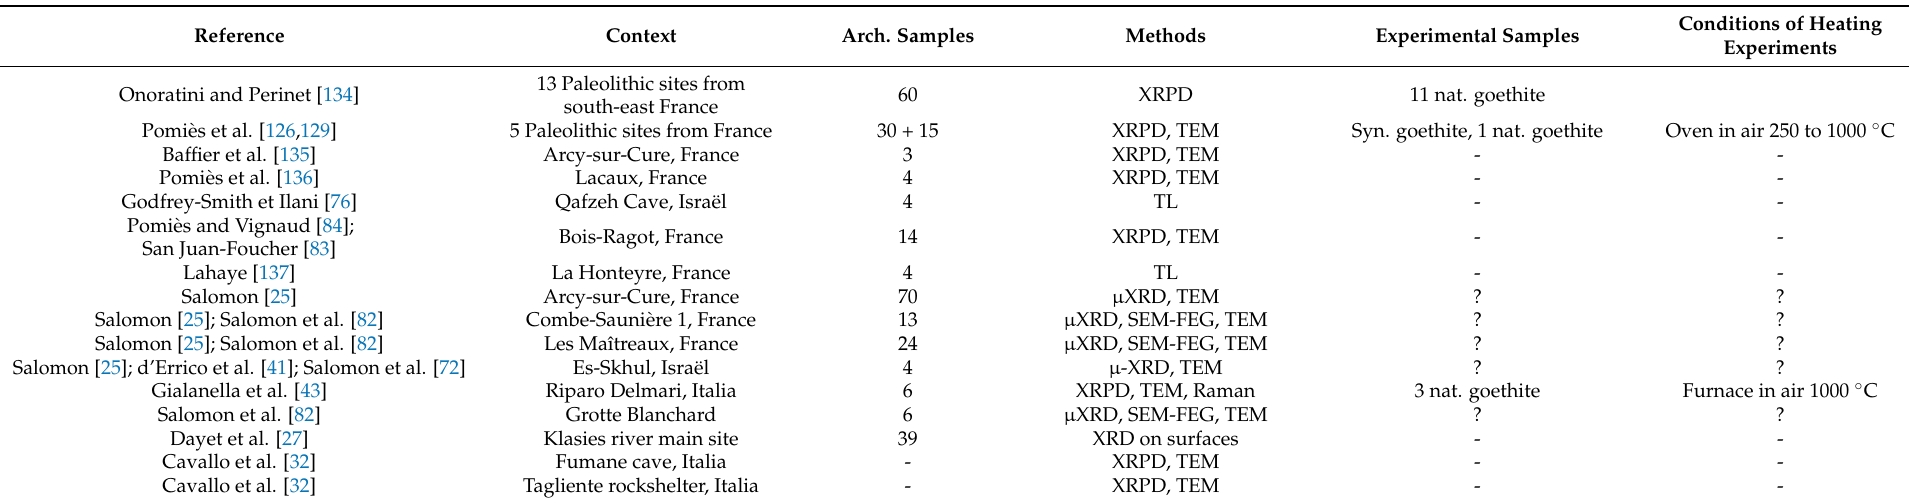
Table 3. Short description of the various methodologies developed for the study of heat treatment features in ochre and iron-bearing geomaterials.